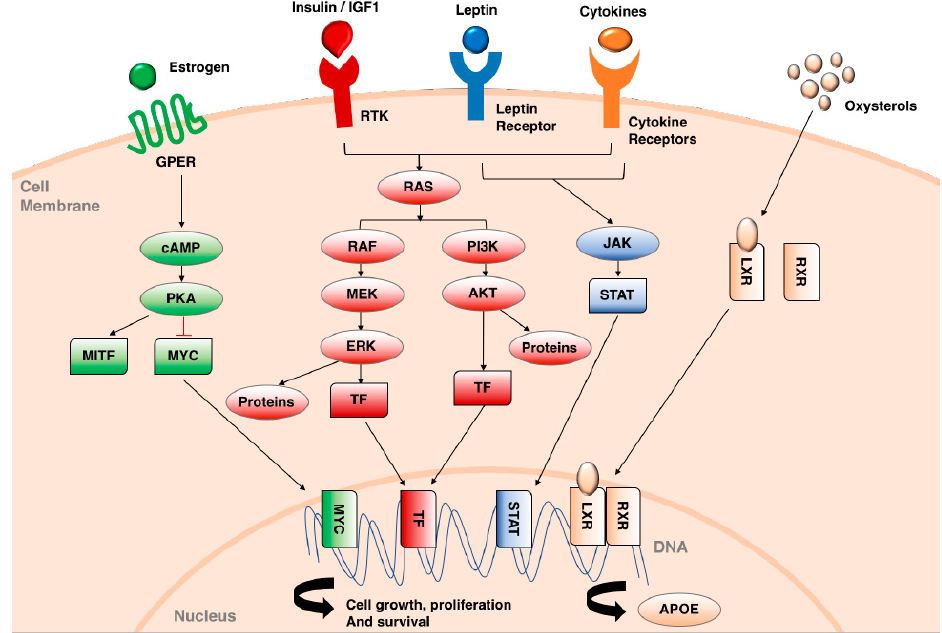
Figure 1. Signaling pathways activated by obesity-induced factors. Circulating factors increased